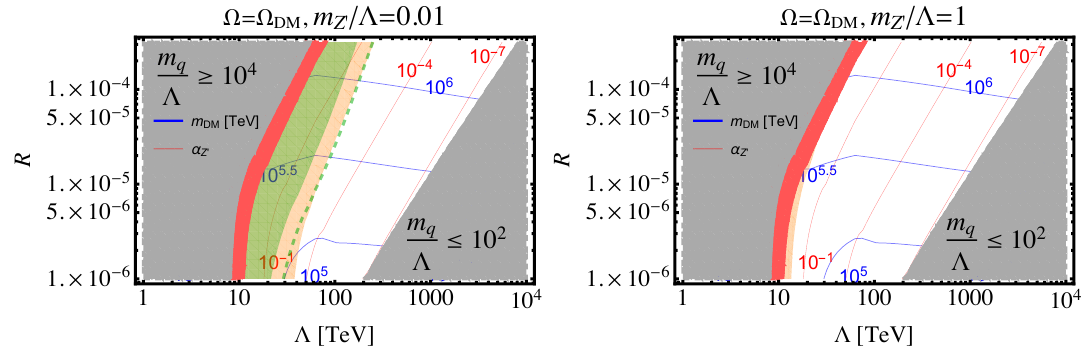
Figure 8 . The available parameter space of the model. We use the maximum dilution assumption and fix the relic abundance to the observed value to calculate α Z 0 and dark matter mass as a function of Λ and R . Contours of α Z 0 (red) and dark matter mass (blue) are shown. In the gray region we fall outside the m q / Λ window where the analysis of ref. [49] is viable. The red region denotes where values of α Z 0 required by the maximum dilution assumption exceed of perturbativity is violated. Bounds from direct detection (green) and collider searches (orange) are shown as well, see the previous sections for further details; the dashed green line denotes the boundary of neutrino floor in direct detection searches; novel search techniques are required to probe the parameter space to the right on this line in direct detection experiments. These bounds can change as m Z 0 varies. We find a large available parameter space. Depending on the value of R , whose precise calculation would require further extensive numerical work including lattice simulations, we can get the right DM abundance with DM masses roughly in the